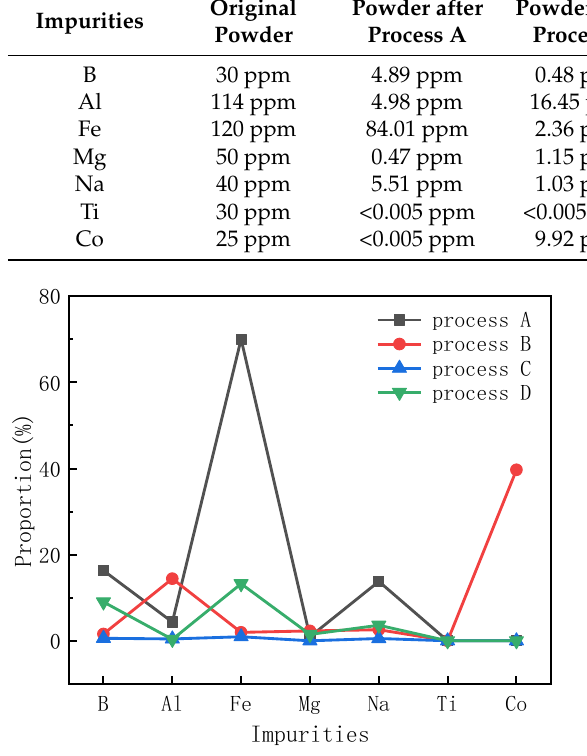
Figure 6. Proportion of sample impurities to impurities in raw powder.